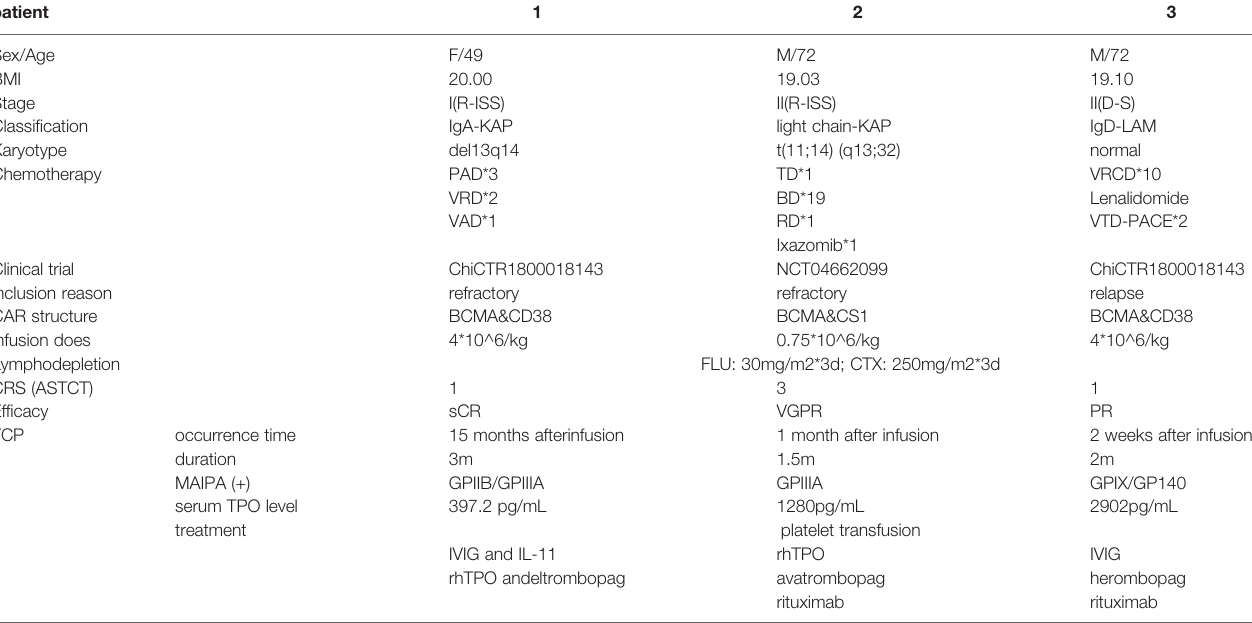
TABLE 1 | Clinical information of 3